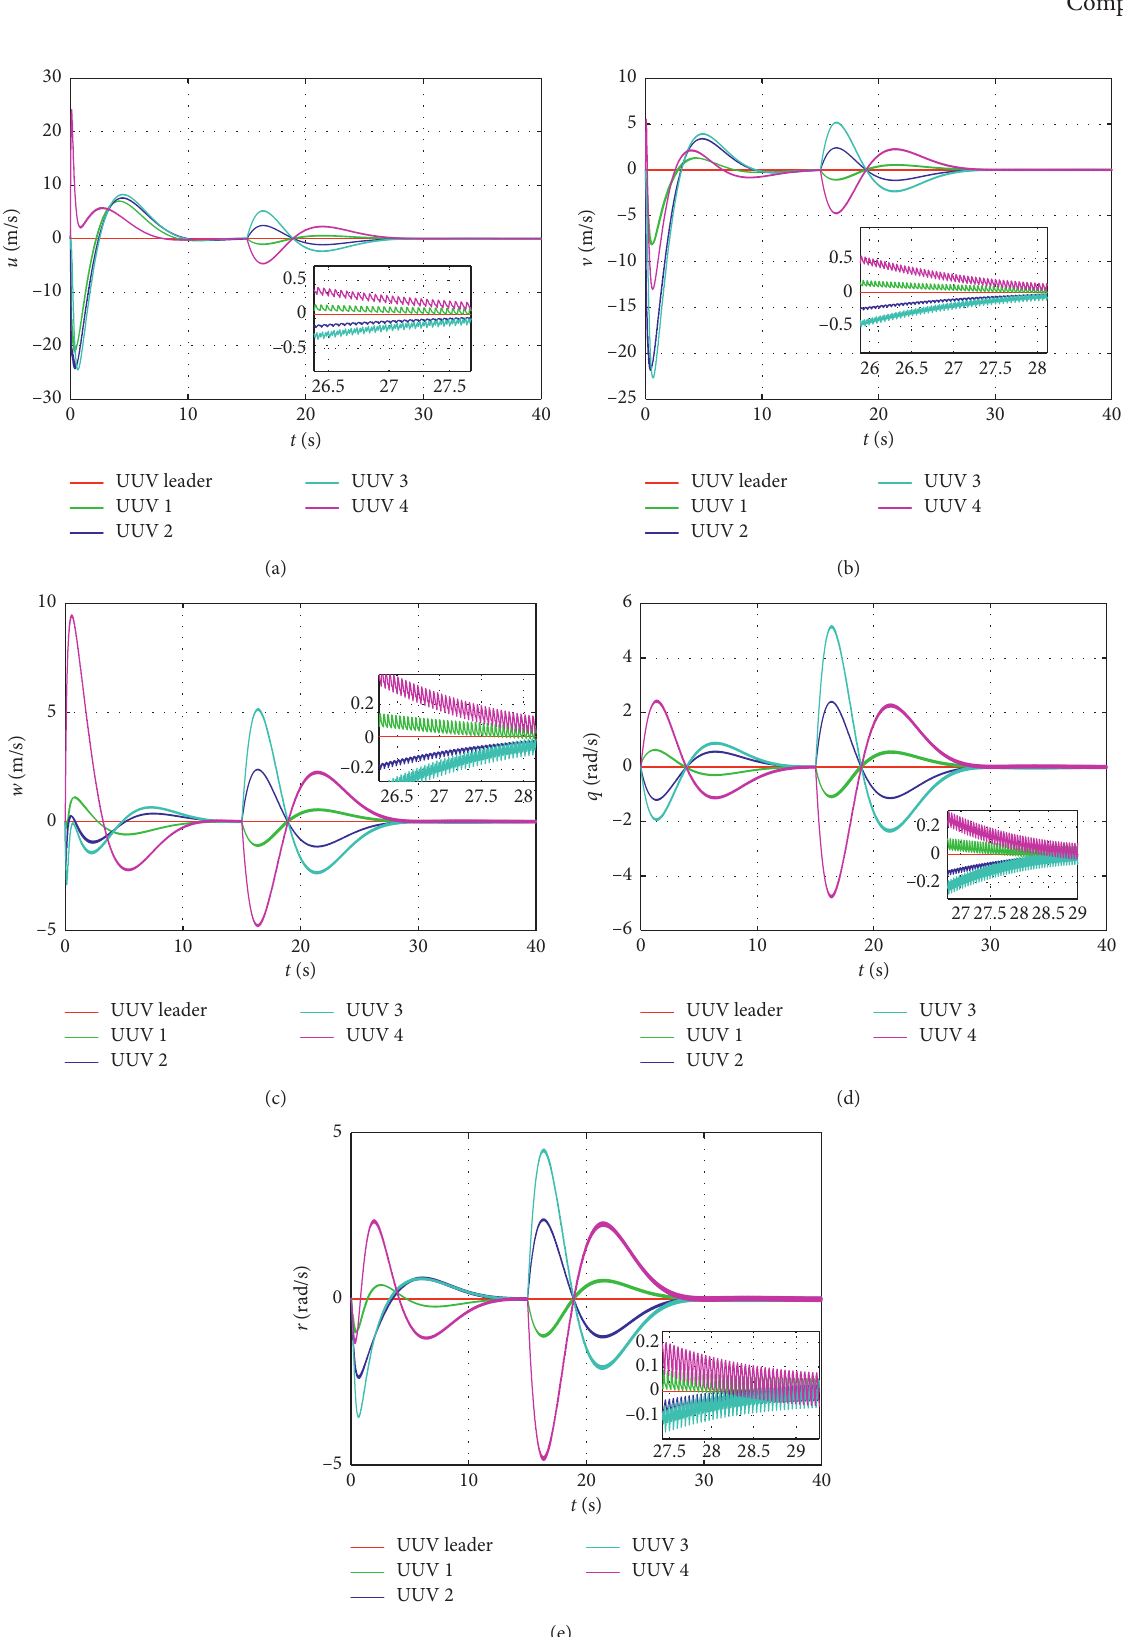
Figure 11: Velocity states of leader-following multi-UUVs with